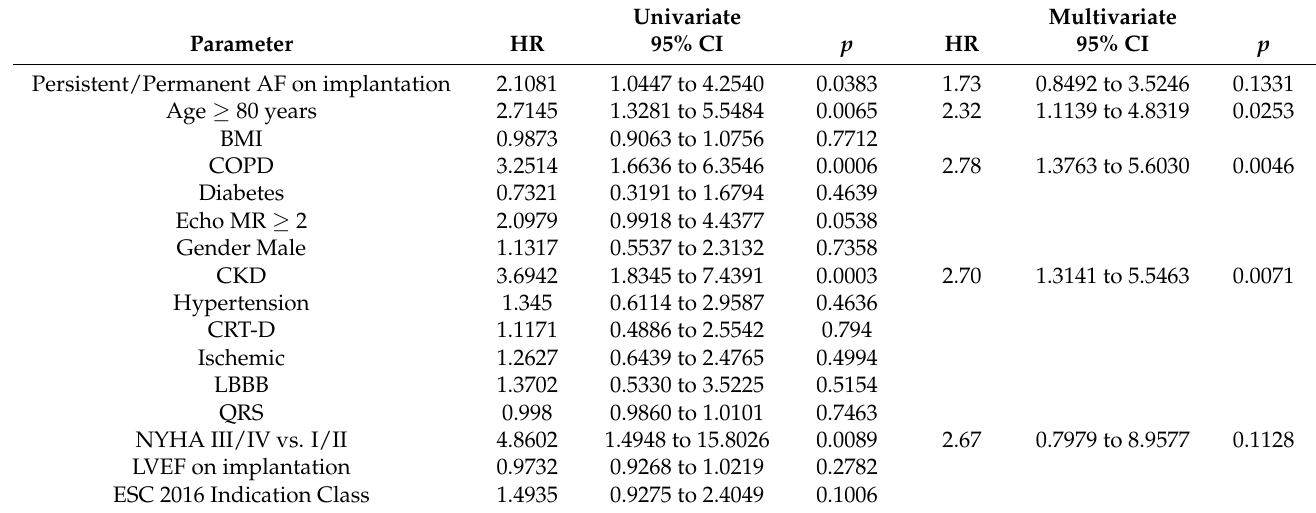
Figure 3. Positive Clinical Response and worsening of clinical composite score (CCS) according to the number of Risk Factors. As the number of risk factors increased, positive clinical response decreased ( 1 ) and rates of worsened CCS increased ( 2 ) (310 out of 345 cases available). Table 4. Predictors of death at 1 year in the elderly